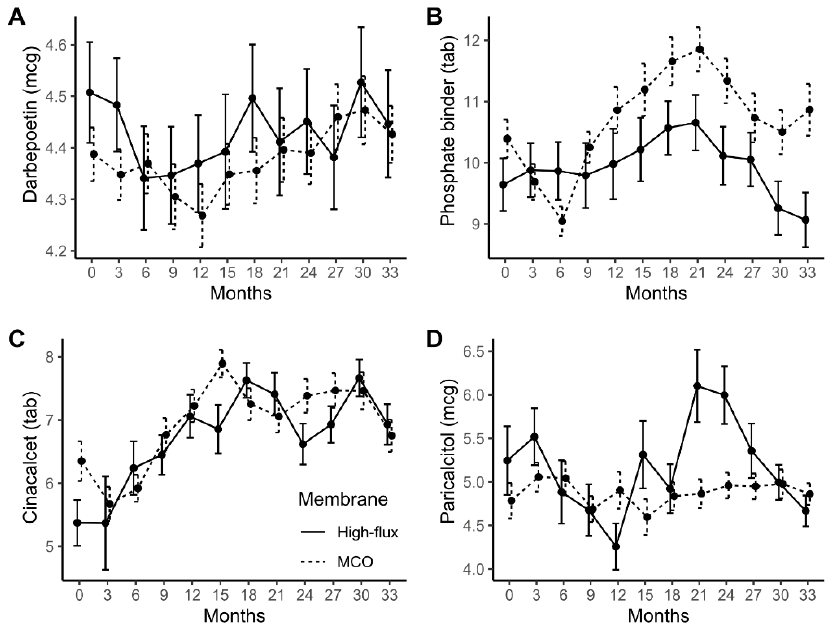
Figure 3. Changes in medication usage during the three-year treatment period according to the membrane type. The average monthly doses of darbepoetin ( A ), phosphate binders ( B ), cinacalcet ( C ), and paricalcitol ( D ) are shown. Data are presented as arithmetic means (black dots) and standard errors (error bars) as an error bar plot. The darbepoetin and paricalcitol doses are expressed in microgram units. The amounts of phosphate binders and cinacalcet are expressed in tablet numbers. The values of the high-flux group are represented as solid lines and those of the MCO group as dash lines. Darbepoetin doses were log transformed. The quantities of phosphate binder, cinacalcet, and paricalcitol were square-root transformed. Phosphate binder included calcium carbonate, calcium acetate, and sevelamer. MCO, medium cut-off membrane.